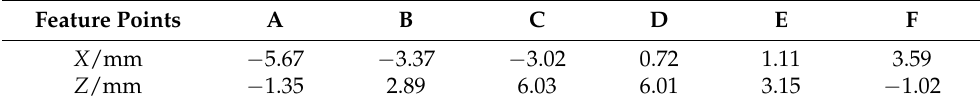
Table 2. Results of initial